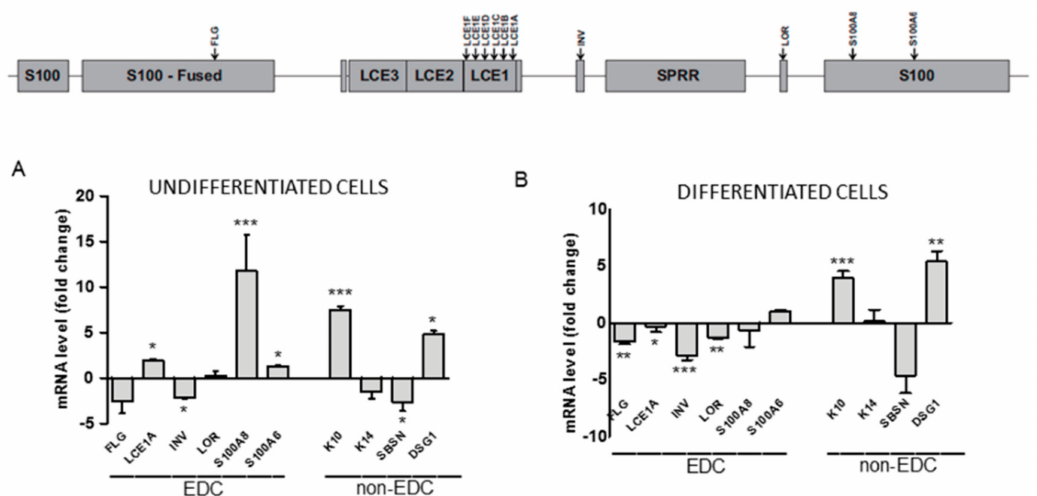
Figure 2. Changes in mRNA level of selected EDC and non-EDC genes in SUV39H1-KO HaCaT cells. Upper panel—schematic representation of EDC; position of the examined genes is indicated by arrows. Lower panel—fold di ff erence in gene expression in ( A ) undi ff erentiated and ( B ) di ff erentiated SUV39H1-KO HaCaT cells over WT HaCaT cells. The bars represent mean ± SEM calculated from n = 3–5 (depending on the gene) RT-qPCR experiments. Each experiment consisting of three technical replicates and was performed on a di ff erent batch of RNA. Statistically significant di ff erences are indicated by asterisks; * p ≤ 0.05, ** p ≤ 0.01, *** p ≤